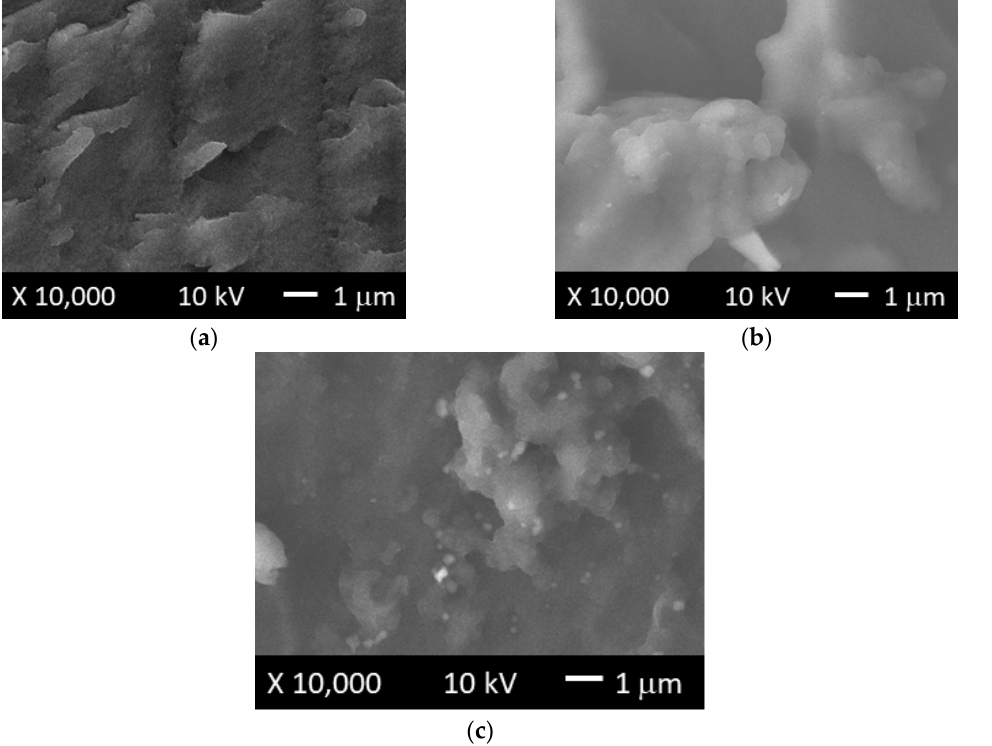
Figure 9. SEM micrographs of ( a ) CC04 copolymer, and ( b ) CCH04 and ( c ) CCP04 nanocomposites.